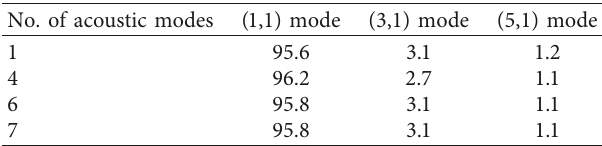
Table 4: Mode contribution at the (1,1) mode peak frequency ( κ � 0.2, ζ � 0.02).